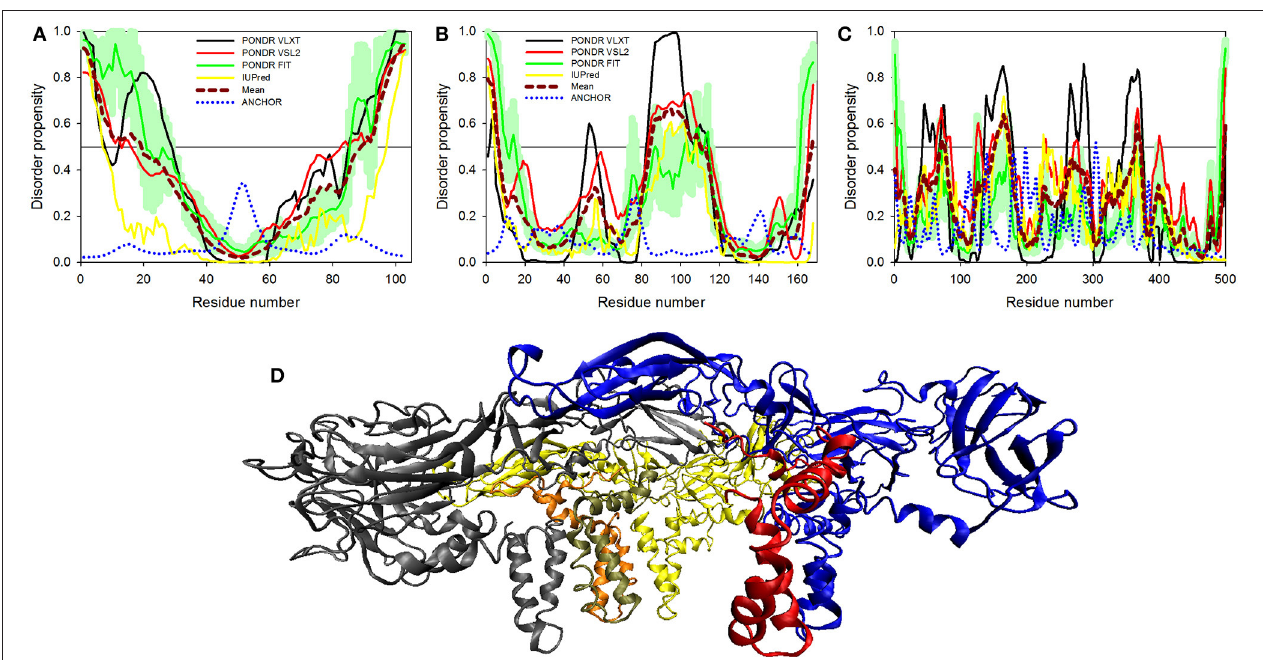
FIGURE 4 | Disorder predisposition of structural proteins of Zika virus. (A) Capsid protein. (B) prM protein. (C) Protein E. Disorder profiles generated by PONDR ® VLXT, PONDR ® VSL2, PONDR ® FIT, and IUPred are shown by black, red, green, and yellow lines, respectively. Dark red dashed line shows the mean disorder propensity calculated by averaging disorder profiles of individual predictors. Light green shadow around the PONDR ® FIT shows error distribution. Blue dotted lines correspond to the result of the functional disorder analysis using ANCHOR algorithm. (D) 3D-structure of the trimer of E-M dimers (asymmetric unit) found in the ZIKV mature viral particle. This complex is formed between three E-M dimers colored as blue-red, gray-orange, and yellow-tan pairs, where structures of the E protein are shown in blue, gray and yellow, and where structures of the M protein are colored as red, orange and tan. The structure of the mature particle of Zika virus was determined by cryo-EM analysis (PDB ID: 5IRE) (Sirohi et al., 2016). Structural representation have been rendered using VMD (Humphrey et al.,